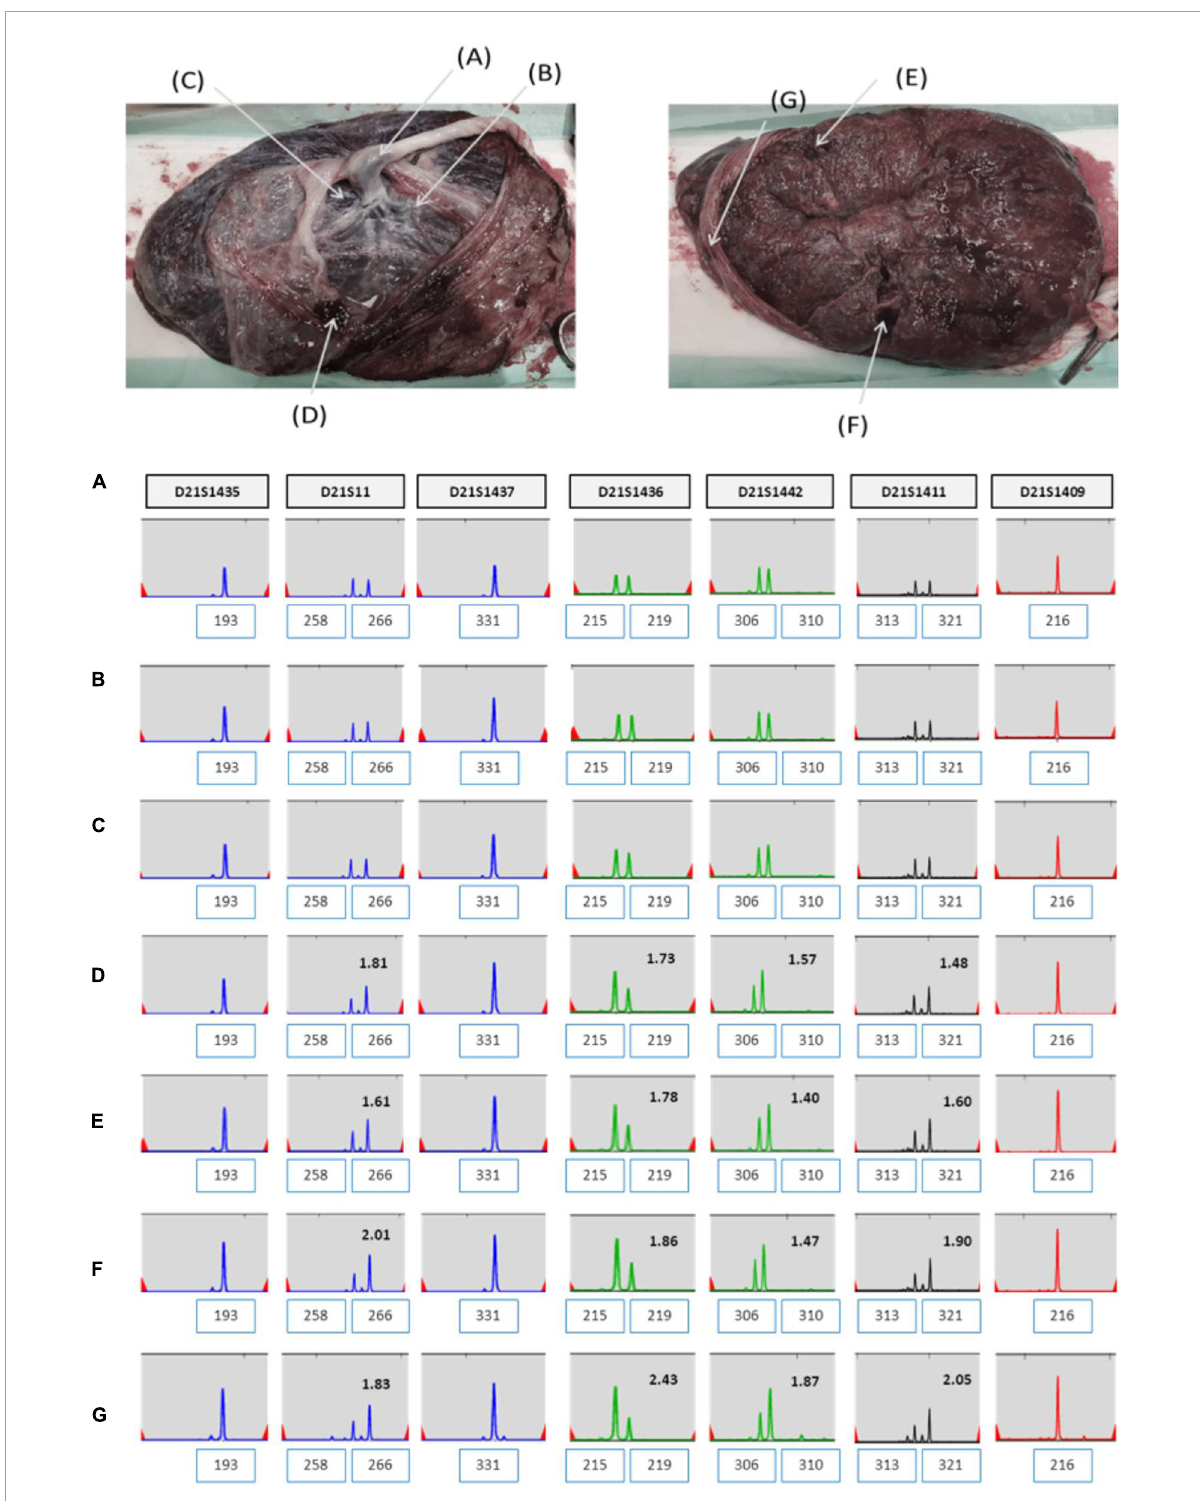
FIGURE4 (A–G) QF-PCR result for chromosome 21 in each location of placenta in case 1 (A) cord blood, (B) chorion, (C) villus parenchyma (fetal side section), (D) villus parenchyma (middle section), (E) villus parenchyma (maternal side section I), (F) villus parenchyma (maternal side section II), (G)